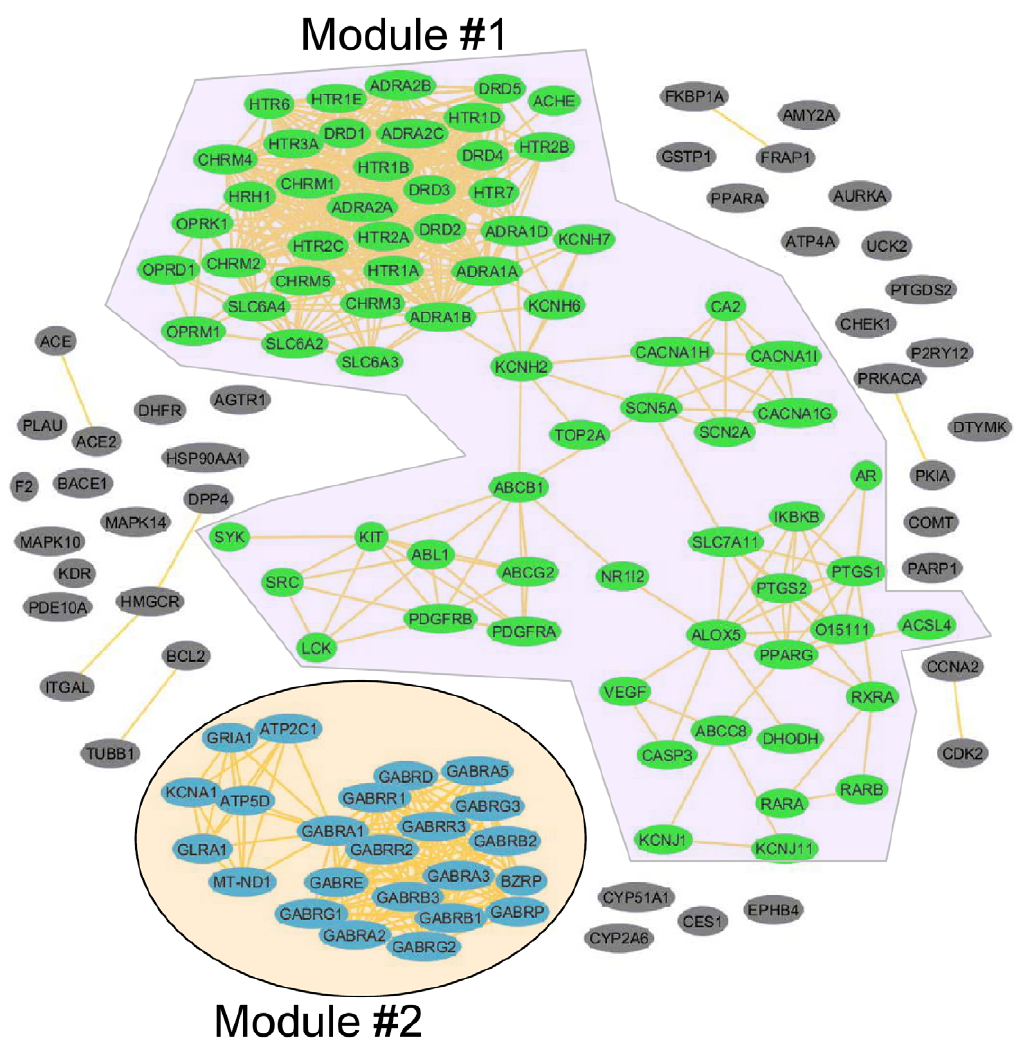
Figure 5. Target network of corresponding drugs satisfying the ‘‘Rule of Three’’.